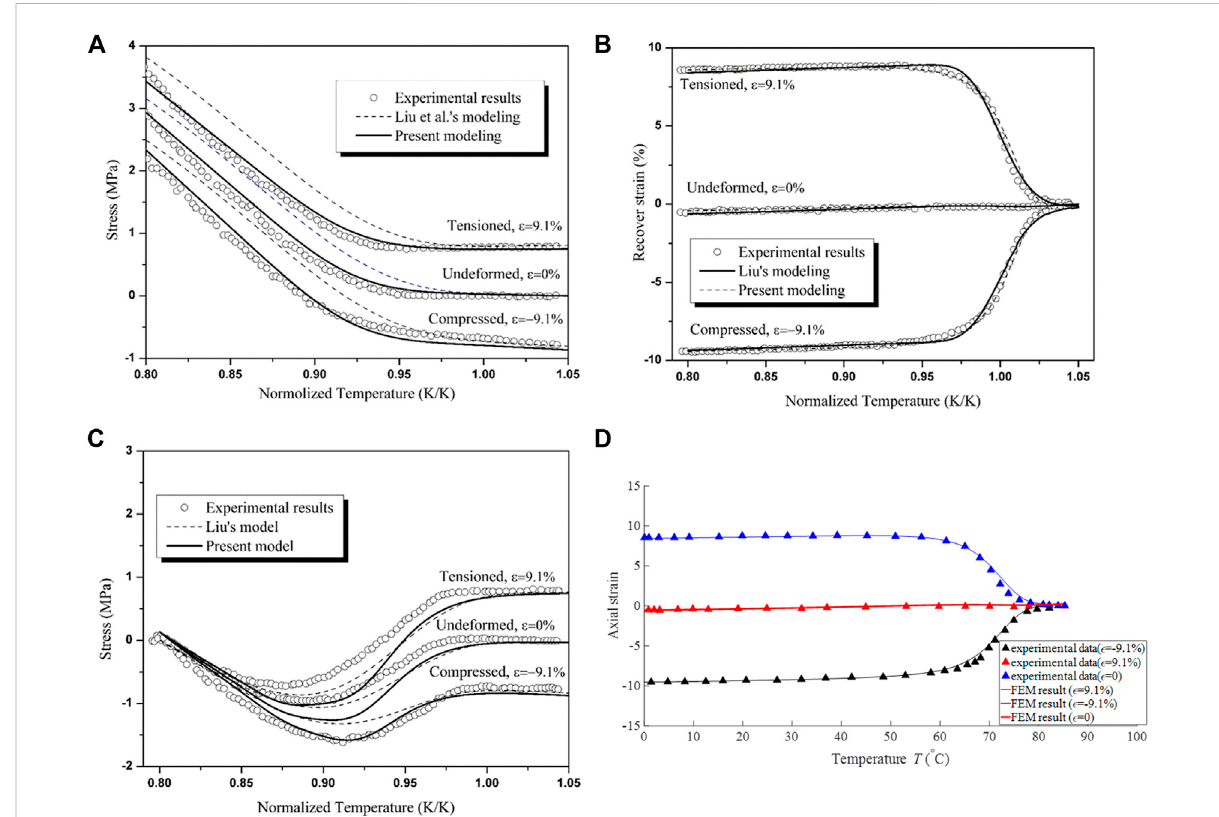
FIGURE 4 Modeling results for (A) stress responses of SMPs during cooling under different pre-strain conditions; (B) free strain recovery tests of SMPs programmed by different pre-strains [Reproduced with permission from International Journal of Plasticity, 80:168-186, (2016). Copyright 2016 Elsevier]. (C) constraint stress recovery tests of SMPs programmed by different pre-strains; (D) comparison between experimental results and fi niteelementanalysisresultsofadogbonespecimenunderuniaxialloading[ReproducedwithpermissionfromSmartMaterialsandStructures, 28: 095030, (2019). Copyright 2019 IOP].